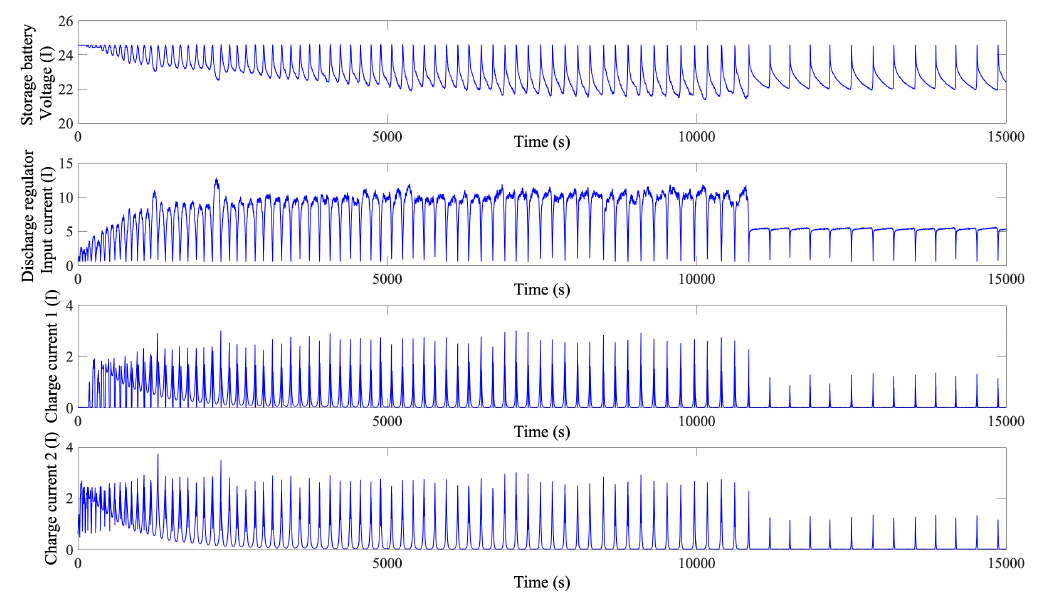
Figure 2. Relationships between the voltage of the storage battery and current parameters after the extraction process. (Subfigure 1 is the storage battery voltage, subfigure 2 is the discharge regulator input current, subfigure 3 is the charge current 1, subfigure 4 is the charge current 2.)